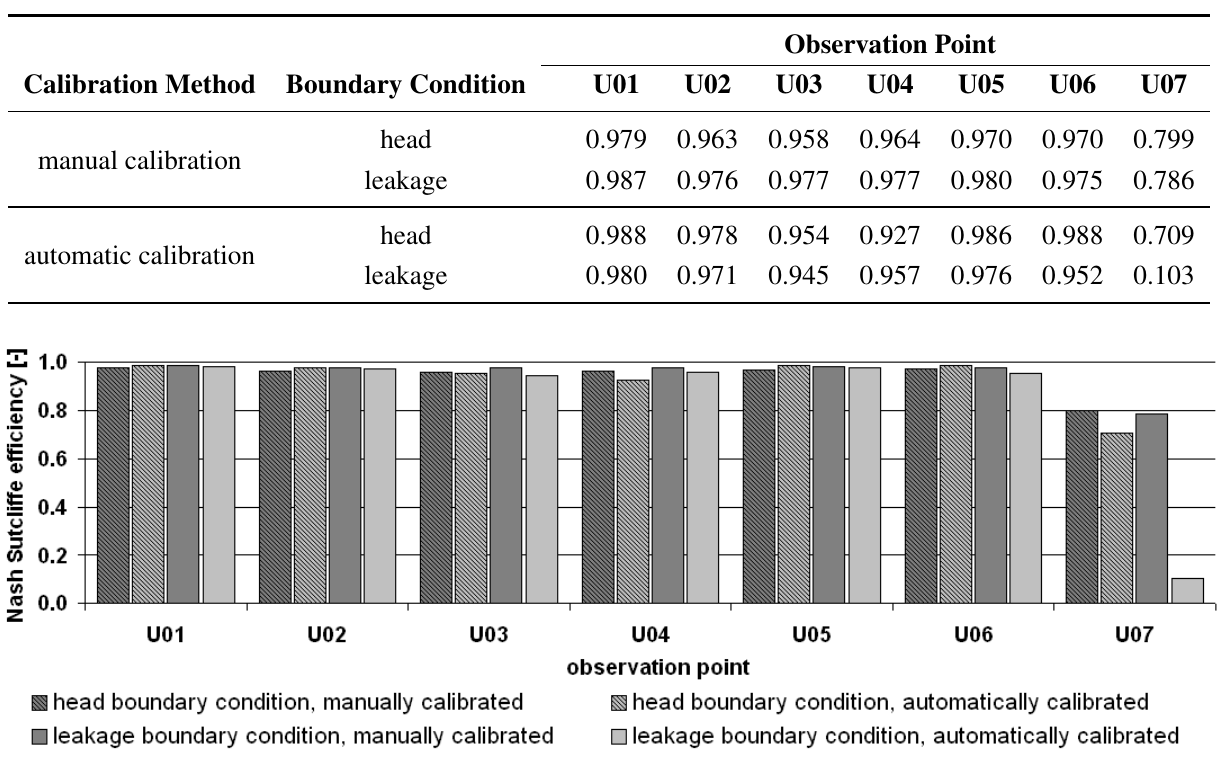
Table 4. Nash–Sutcliffe efficiency of the observation points obtained by manual and automatic calibration for the two model variants.